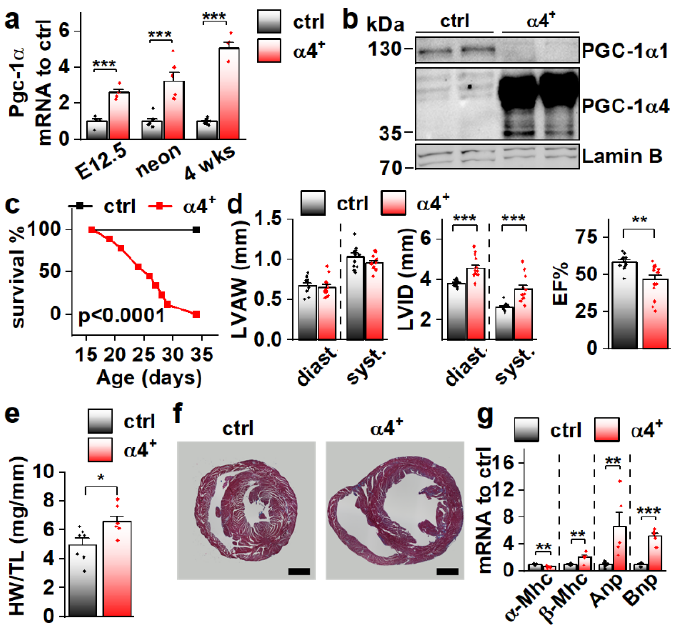
Figure 2. Cardiomyocyte-specific PGC-1 α 4 Overexpression in Mice Leads to Early Death by Dilated Heart Failure. ( a ) Total Pgc-1 α gene expression in the ventricles of embryonic day 12.5 (E12.5, n [ctrl] = 4, n [ α 4 + ] = 4), neonatal (neon, n [ctrl] = 6, n [ α 4 + ] = 6) and 4-week-old ( n [ctrl] = 7, n [ α 4 + ] = 5) Pgc-1 α 4 overexpressing mice ( α 4 + ). ( b ) Protein expression of PGC-1 α isoforms 1 and 4 in the nuclear fraction from left ventricular tissue of control and α 4 + mice at the age of four weeks. ( c ) Survival of control ( n = 13) and α 4 + ( n = 9) mice after genotyping. Statistical significance was determined using a Log- rank (Mantel–Cox) test. ( d ) Left ventricular anterior wall thickness (LVAW, left), left ventricular inner diameter (LVID, middle) and Ejection fraction (EF, right) assessed with echocardiography in